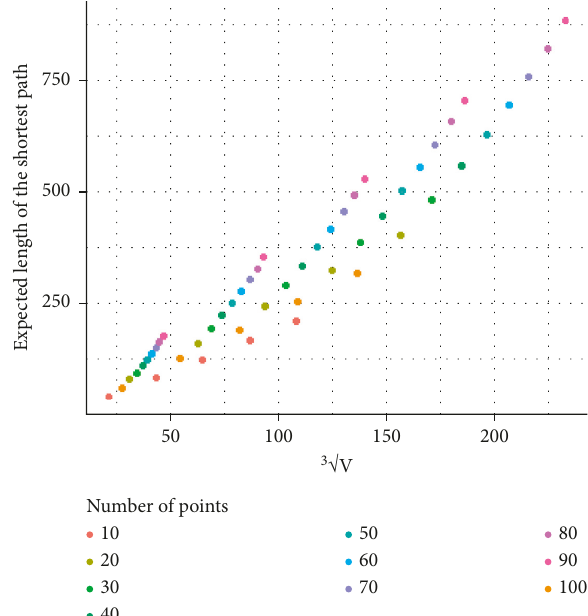
(cid:31)(cid:31)(cid:31)(cid:31)